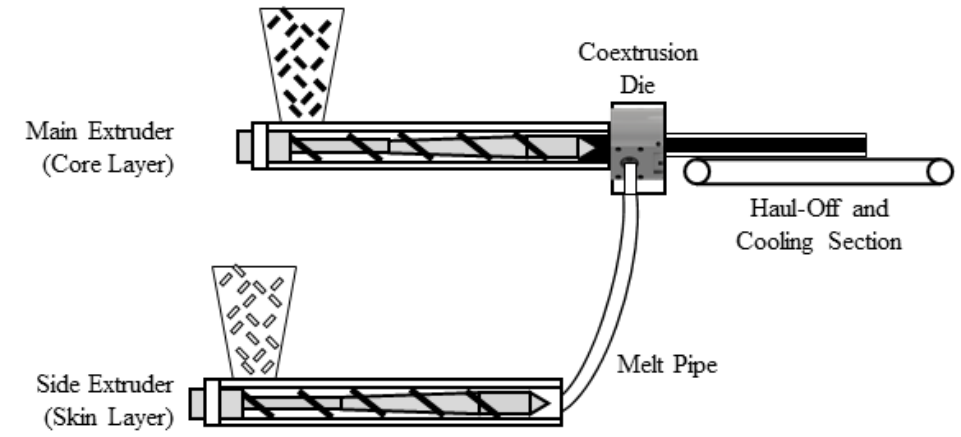
Figure 1. Schematic extrusion line configuration for coextrusion of PLA